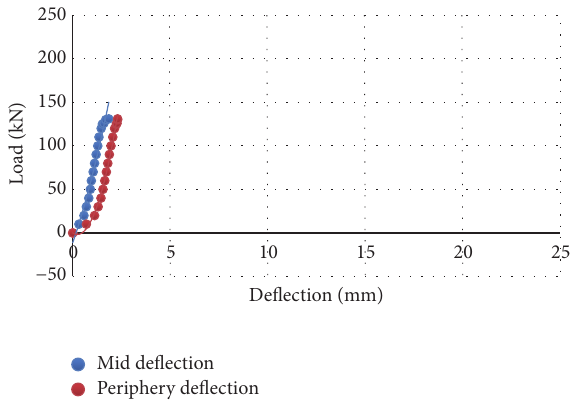
Figure 6: Punching shear values for control mix concrete (GC2).